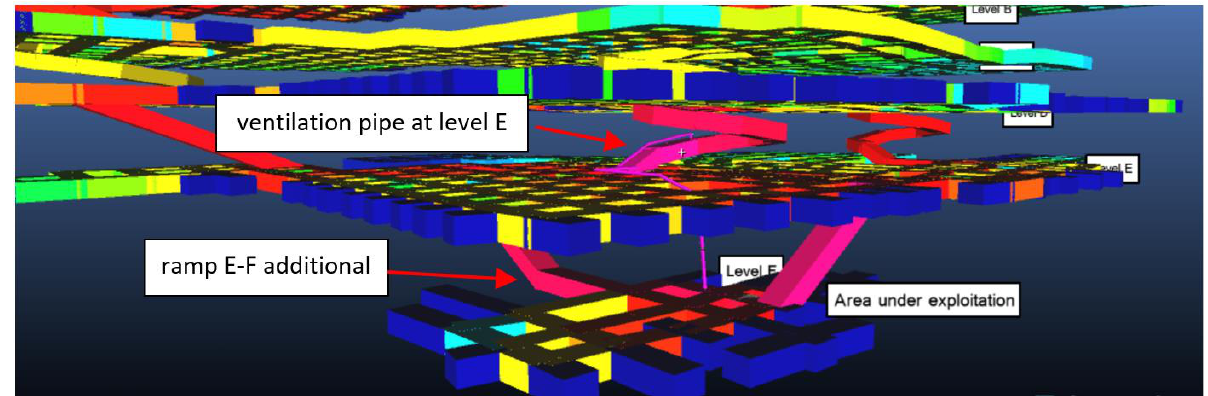
Figure 4. Details of the interventions simulated in the numerical model, as advised in order to improve the ventilation circuit. The second connecting ramp between Levels E and F (ramp E – F additional), as well as the piping at Level E, for connecting the fan outlet with the Prato Nuovo ramp, can be seen.